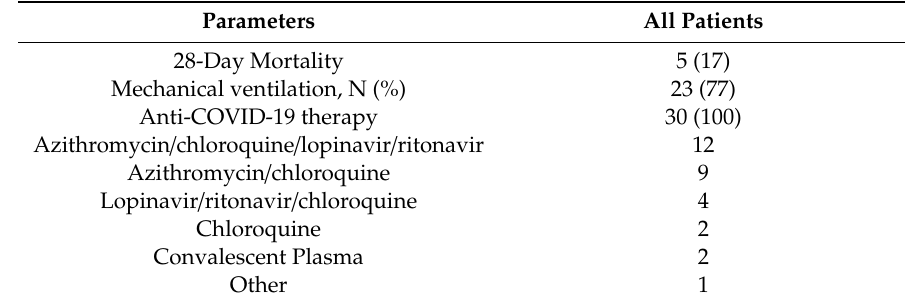
Table 1. Cont. Parameters All Patients 28-Day Mortality 5 (17) Mechanical ventilation, N (%) Anti-COVID-19 therapy